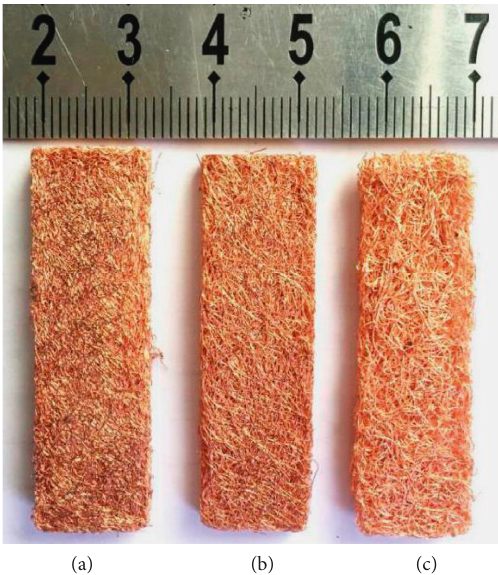
Figure 2: PCFSS samples: (a) ε